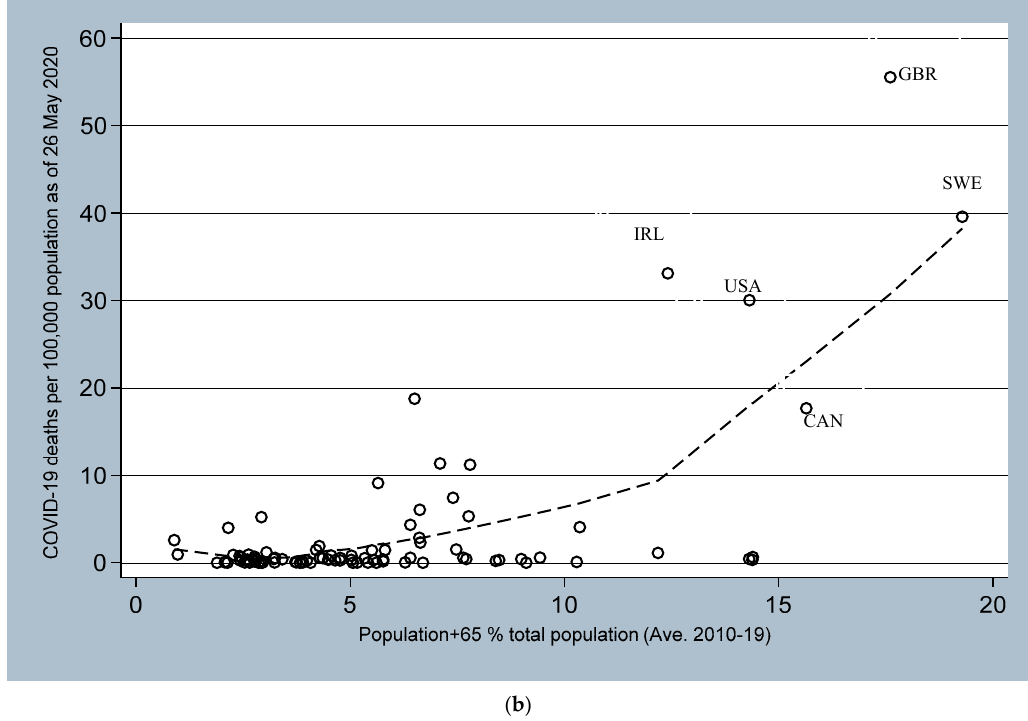
Figure 1. ( a ) COVID-19 mortality per 100,000 people and elderly share of population (Full Sample). ( b ) COVID-19 mortality per 100,000 people and elderly share of population (Sample of countries with hospital beds per 1000 of people < 3 (sample average)). Note: Cumulative COVID-19 death and share of elderly population. These two figures plot the total COVID-19 deaths per 100,000 population (as of 26 May 2020) against elderly population (the proportion of population beyond the age of 65 years in the total population from 2010 to 2019). The figures also include the locally weighted scatterplot smoothing curve (lowess), in which simple regressions are fitted to localized subsets of data to produce the nonlinear curve.